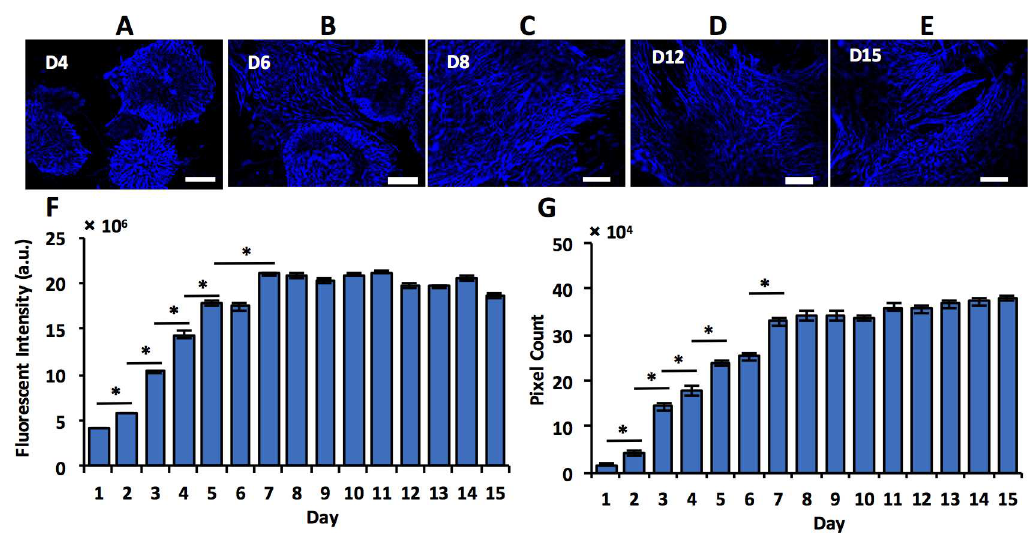
Fig 5. Immunocytochemical analysesof Nestin stained images. (A-E) Differentiating mESCs immunostained for Nestin on different days of co-culture with PA6 cells. (F) Daily fluorescent intensity measurements of Nestin-stained samplesshow that protein expressionincreasesduringthe first week of culture but remainssteady thereafter. (G) Quantification of Nestin expressionusing an adaptive thresholding technique. Scale bar: 100 μ m. * indicates p < 0.05.